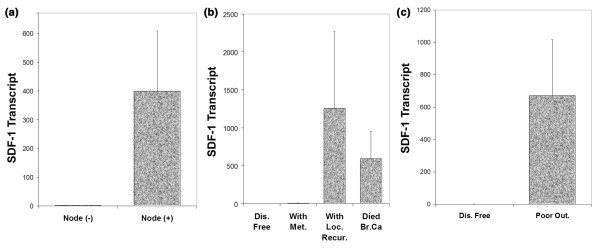
Levels of SDF-1 transcript in human breast tumours. (a) Stromal cell-derived factor (SDF)-1 expression level and lymph node metastasis, showing SDF-1 expression in node-negative and node-positive samples (0.89 ± 0.47 versus 399 ± 210; P = 0.05). (b) Significantly raised SDF-1 transcript in patients with local recurrence and with mortality. (c) Expression level of SDF-1 and clinical outcome (disease-free versus poor out come: 0.83 ± 0.35 versus 670 ± 346; P = 0.01).